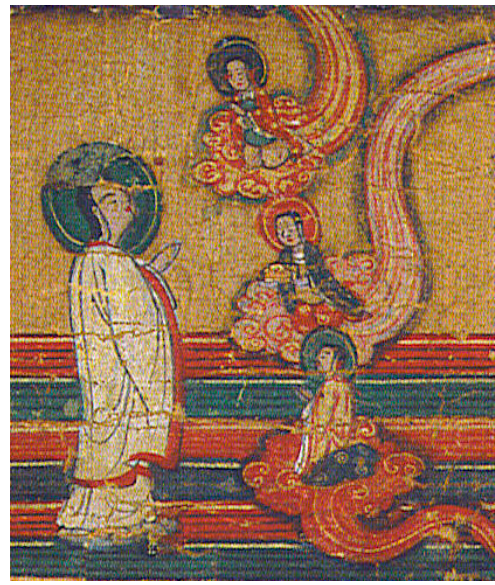
Figure 6. Mani the Buddha of Light (Yoshida and Furukawa 2015, Plate 5).